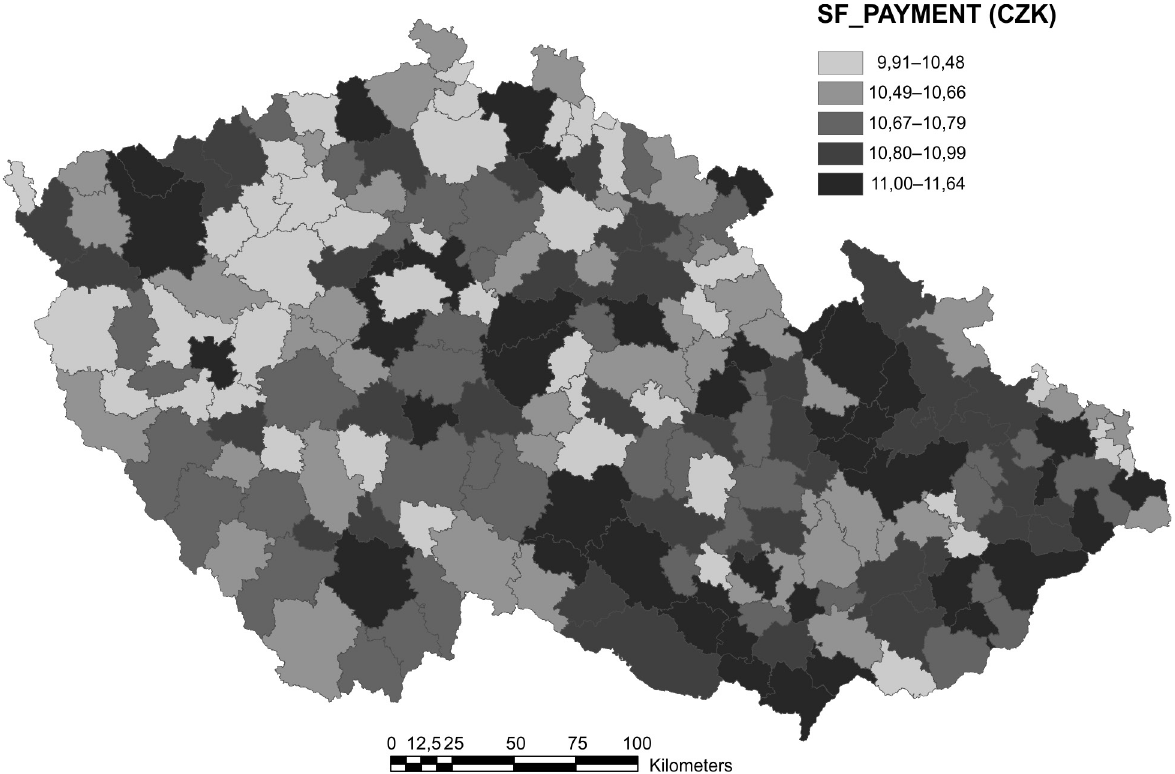
Fig. 1. SF_PAYMENT –